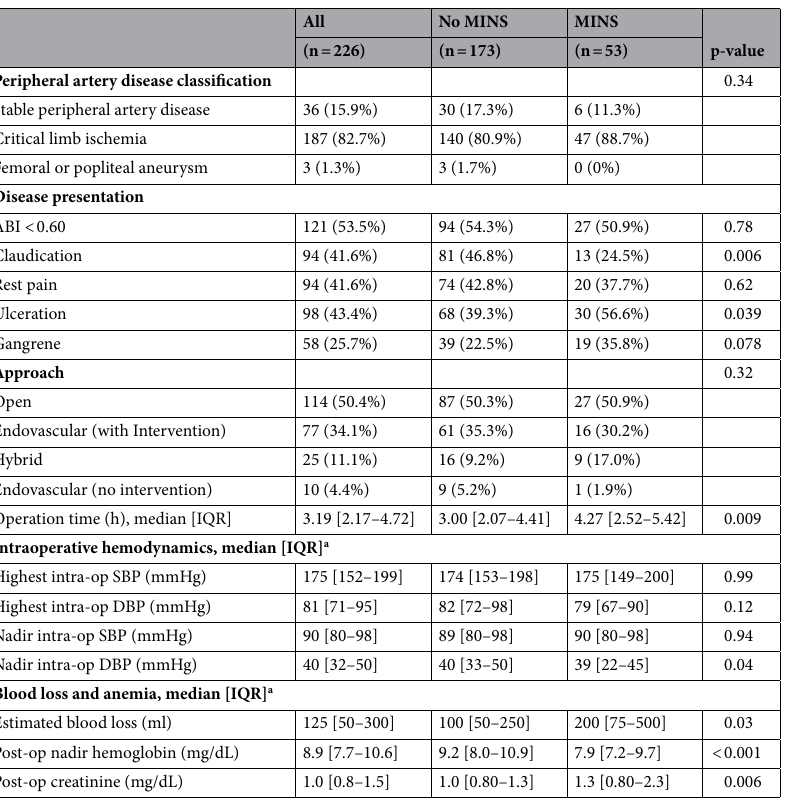
Table 2. Surgical characteristics of lower extremity revascularization. DBP diastolic blood pressure, SBP systolic blood pressure. a Intraoperative hemodynamic and laboratory data were available in a subset of patients.